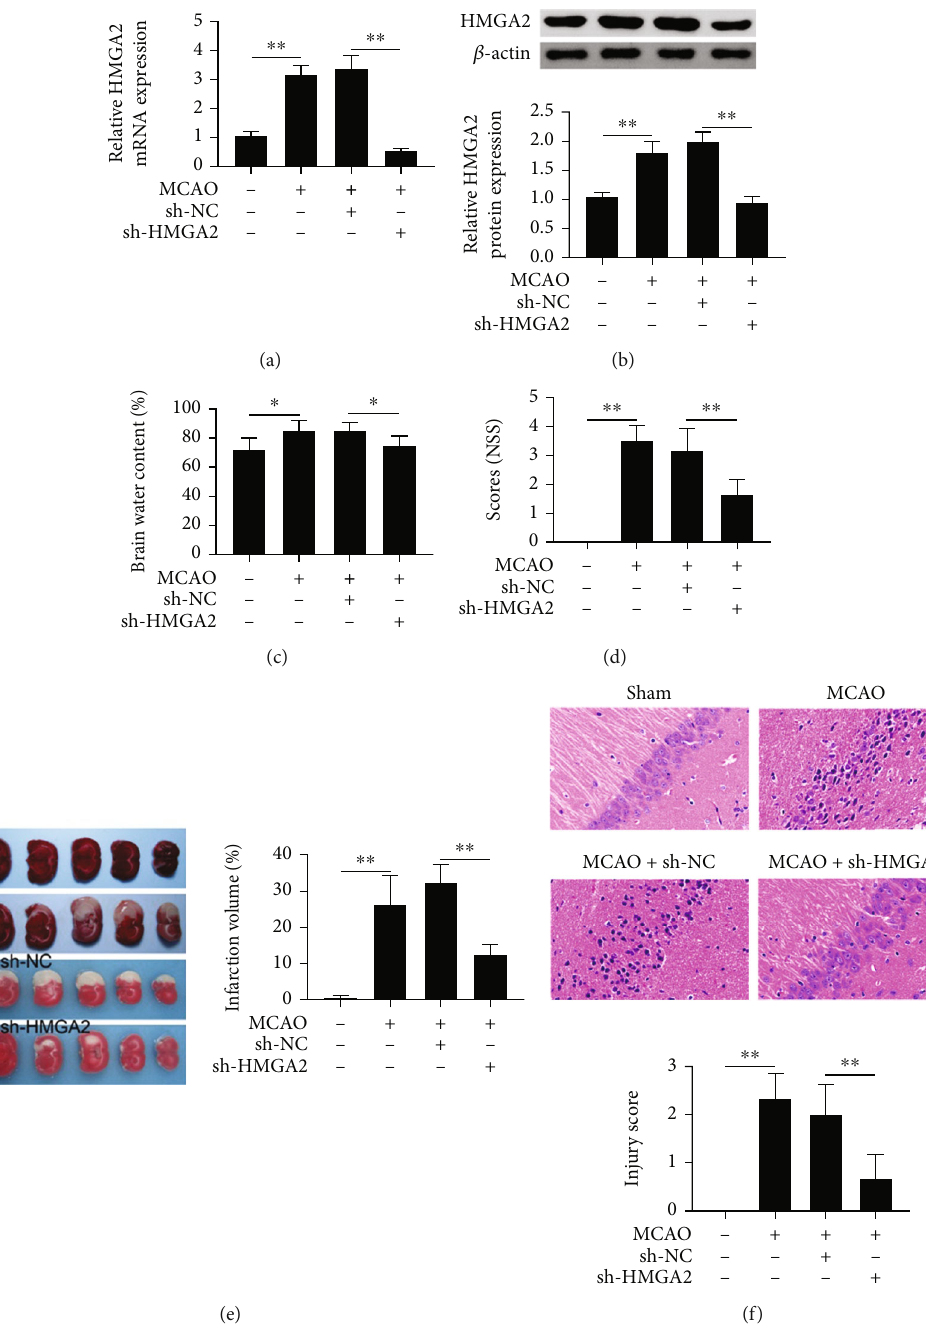
Figure 1: The e ff ects of HMGA2 on neuron function and brain injury in cerebral infarction rats. (a) Quantitative PCR was performed to examine the mRNA expression level of HMGA2. (b) Western blot was used to explore the protein expression level of HMGA2. (c) Cerebral tissue water content after cerebral infarction compared. (d) Neurological severity scores were evaluated the neuron function. (e) TTC staining was used to explore the infarct volumes after MCAO. (f) H&E staining to analysis the brain tissue sections in cerebral infarction rats. ∗∗ p < 0 : 01 vs. sham or MCAO + sh-NC. ∗ p < 0 : 05 vs. sham or MCAO + sh-NC. Data are expressed as mean ± SEM